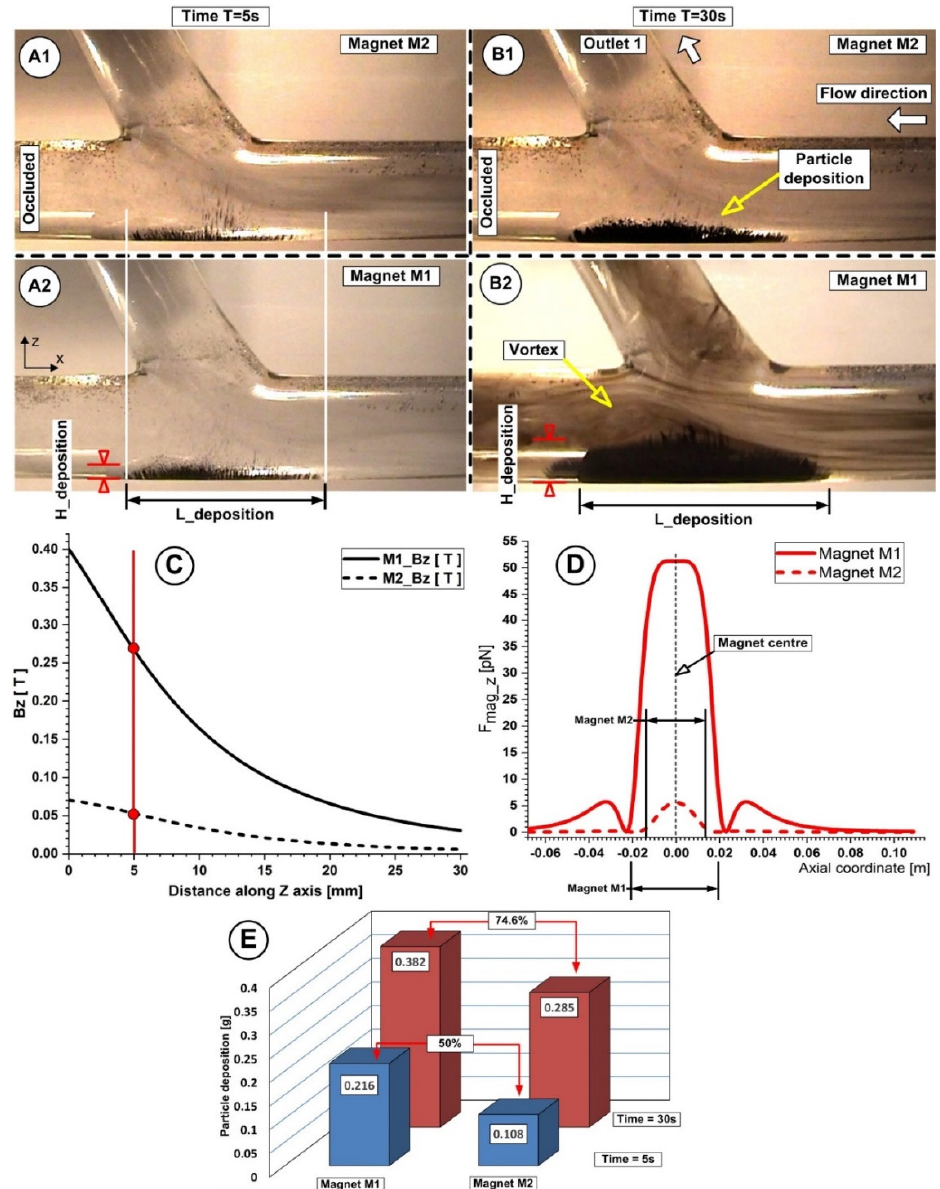
Figure 15. Particle retention dependency of the used magnet types ( A , B ). Particle accumulation evolution at different time steps during the injection period ( A1 , A2 , B1 , B2 ). Magnetic field vertical component values for both magnets at h = 5 mm from the bottom wall of the artery ( C ). Magnetic force distribution for magnets M1 and M2 along the main artery wall ( D ). Comparison of the accumulated particle quantities and percentage differences between the used magnets, corresponding to the different time steps during injection ( E ). Investigations were conducted in the same conditions; distance from the wall of h = 5 mm, injection period of 30 s, flow rate of 362 mL/min, and Reynolds number Re =